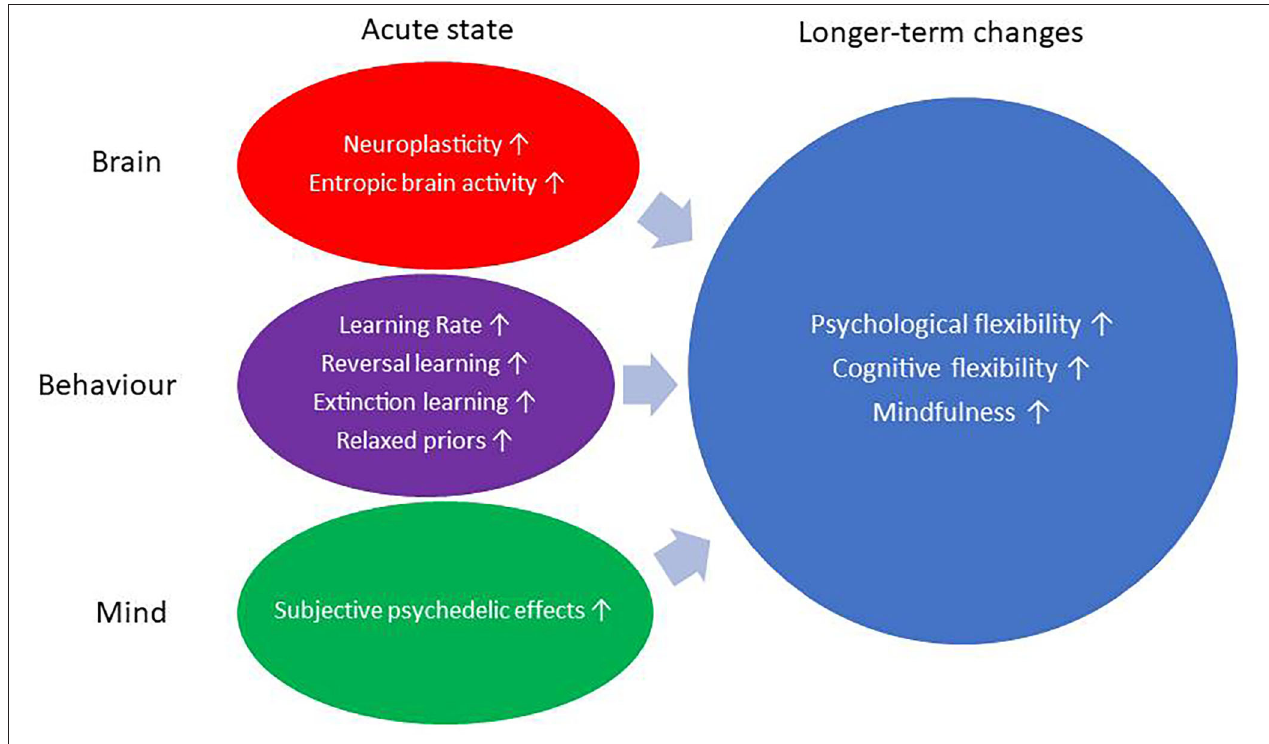
FIGURE 1 | Mind and brain plasticity processes during acute state and follow-up.